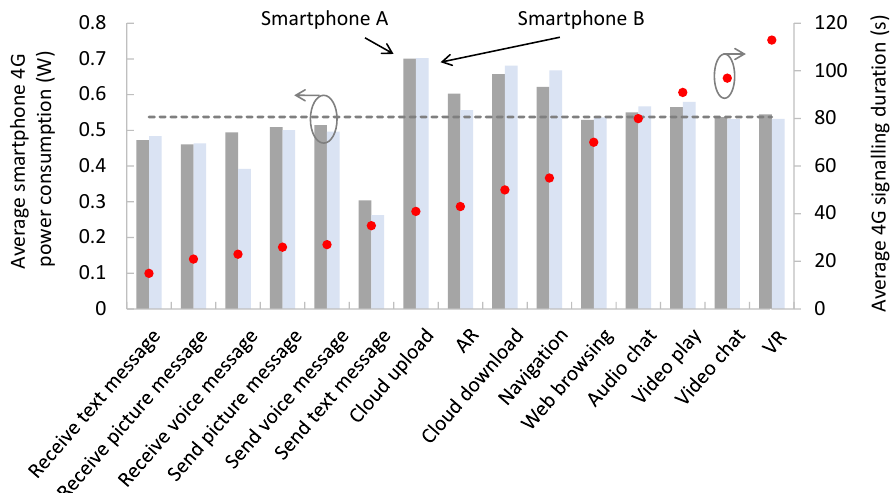
Figure 3. Smartphone’s 4G power consumption and signaling duration for 15 different types of mobile services. Note that the services are sorted by 4G signaling duration and average measurements for 2 types of smartphones are plotted to demonstrate the consistency of the measurements.